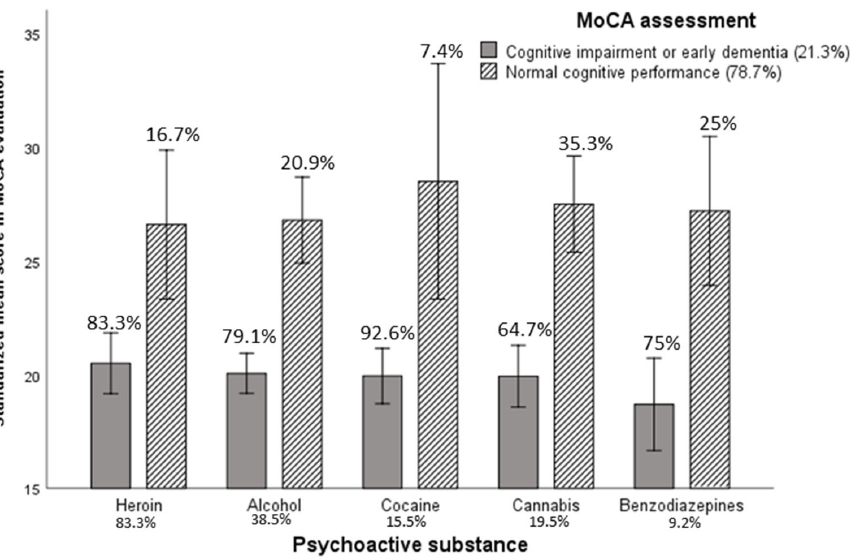
Figure 1. Mean scores of consumers of psychoactive substances in cognitive impairment classification across MoCA scores (Montreal Cognitive Assessment). Note: Scores range from 0 to 30: scores ≥ 26 indicate normal cognitive performance, while scores < 26 indicate mild cognitive impairment or early dementia.